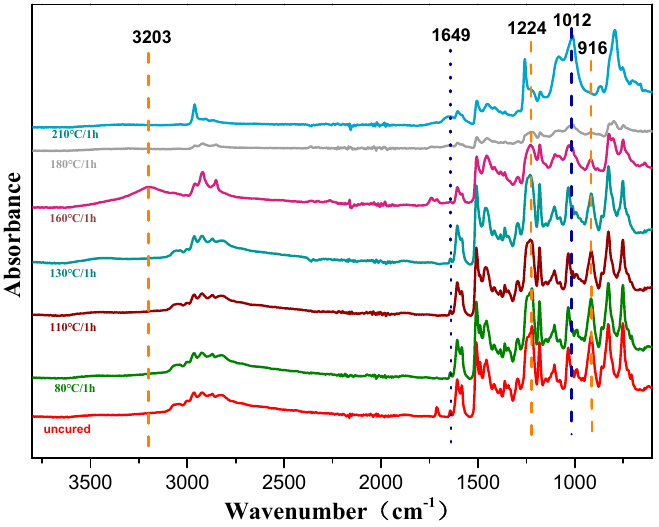
Figure 7. FTIR spectra of prepolymers (5 wt % POSS-PBZ -E) with different curing rates. Table 1. Peak temperature at different heating rates.